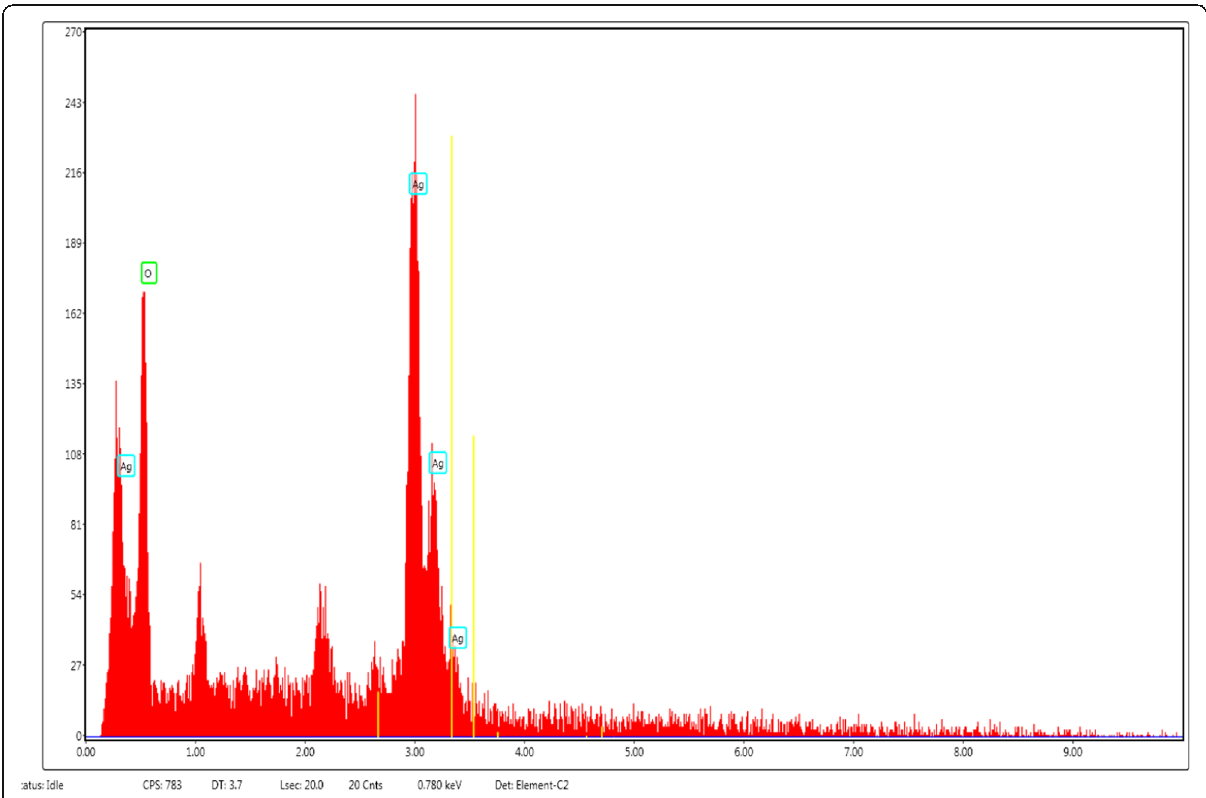
Fig. 4 EDS of chemical mediated silver